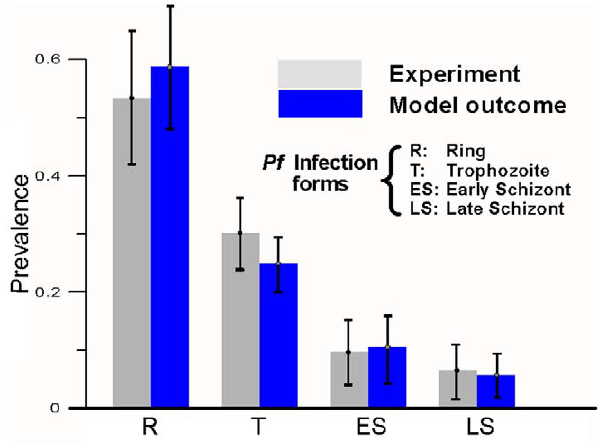
Figure 6. Experimental and simulated prevalence of infection . R = ring, T = trophozoite, ES = early forms S q f INF ð Þ T ST schizont and LS = late schizont. Bars show the prevalent distributions averaged over twenty days for ten culture systems under the standard protocols, with sub-cultivations performed every two, three or four days and with different diversity of the inocula. Error bars correspond to the standard deviation observed through the different . trials s S q f INF ð Þ T ST